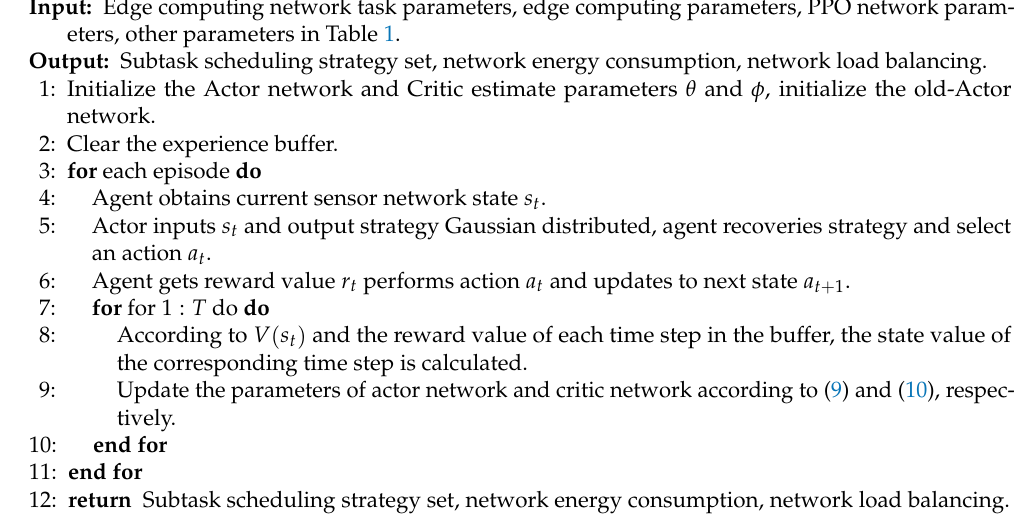
Algorithm 1 PPO Resource Scheduling Algorithm.